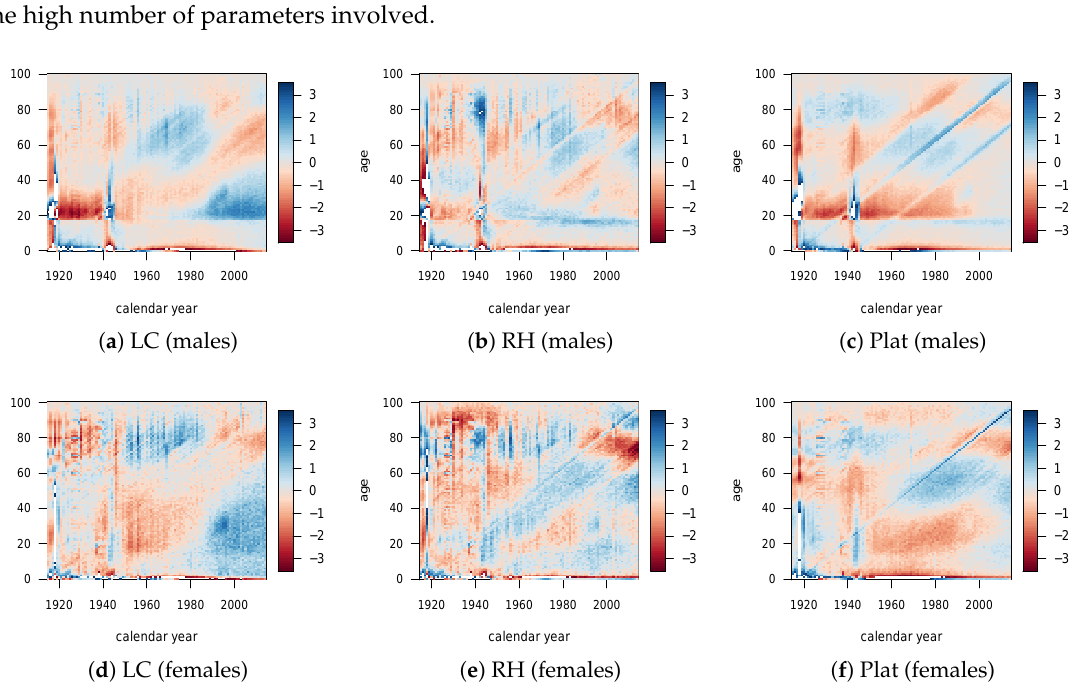
Figure 1. Heat map of standardized residuals of the mortality models. Ages 0–100 and years 1915–2014, Italian